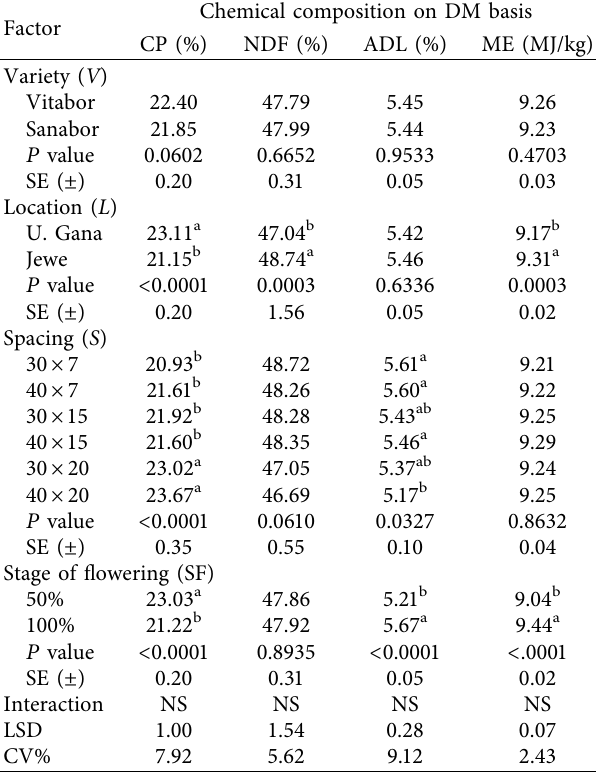
Table 5: Effects of location and spacing on in vitro organic matter digestibility of sweet lupine